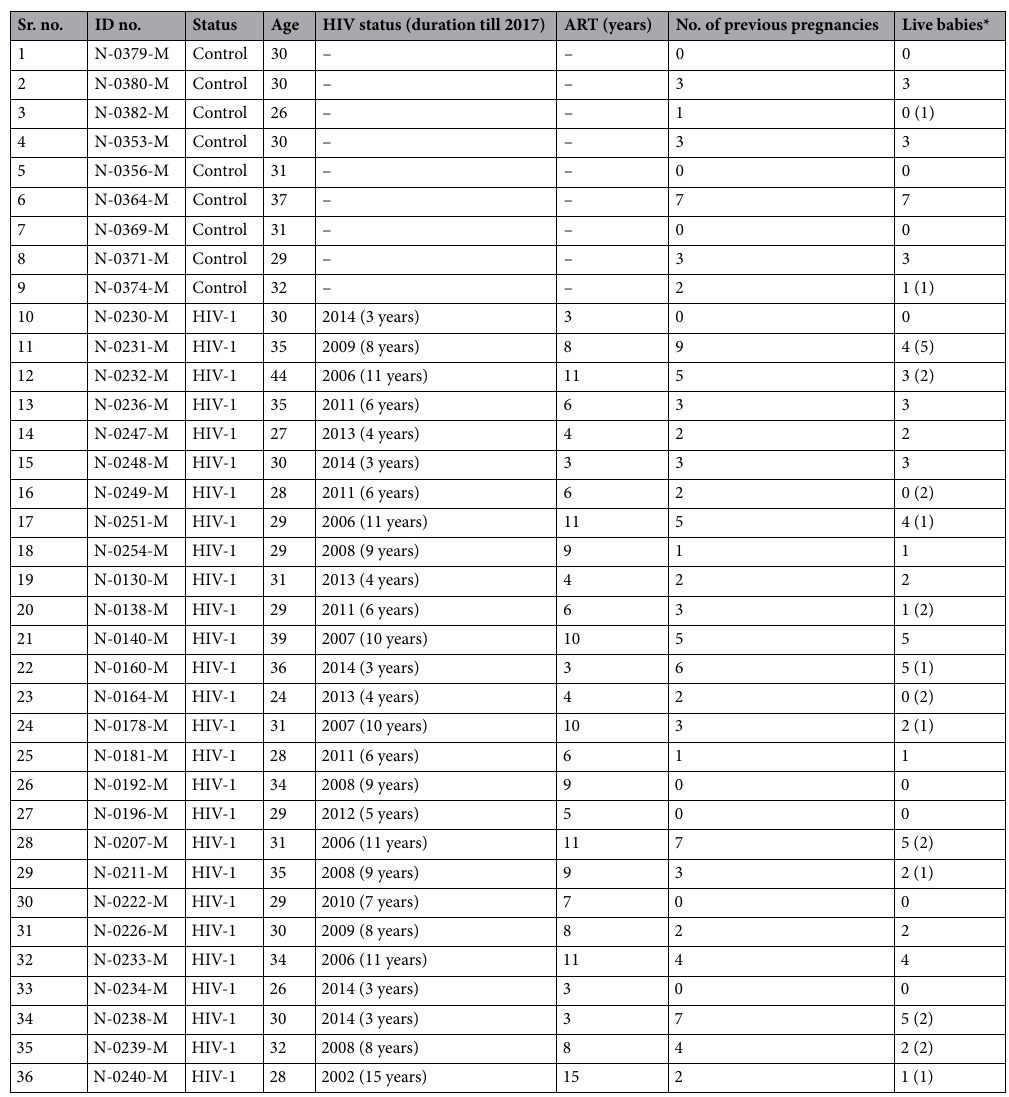
Table 1. Clinical characteristics of HIV-1-infected and uninfected mothers. *Number of deceased are shown in